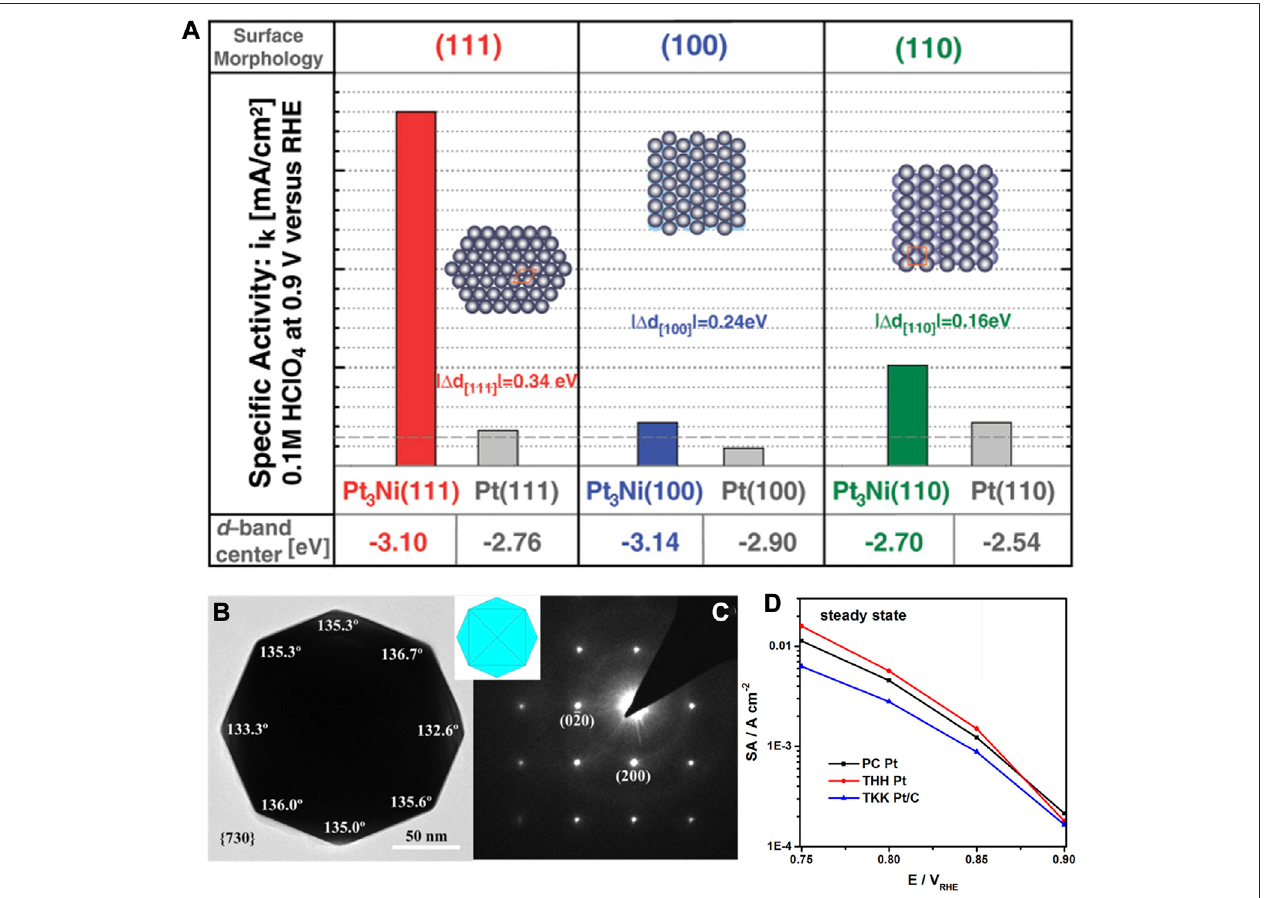
FIGURE 6 | (A) Comparison of d-band center and ORR activity for different crystallographic facets of Pt and Pt3Ni alloy. (B,C) HRTEM image of Pt nanoparticles withtetrahexahedral(THH)shape. (D) Speci fi cactivitiesofpolycrystallinePt,THHPtandTKKPt/Cin0.1 MHClO 4 . (A) Reproducedwithpermission(Stamenkovicetal., 2007). Copyright 2007, American Association for the Advancement of Science. (B – D) Reproduced with permission (Deng et al., 2017). Copyright 2017, American Chemical Society.